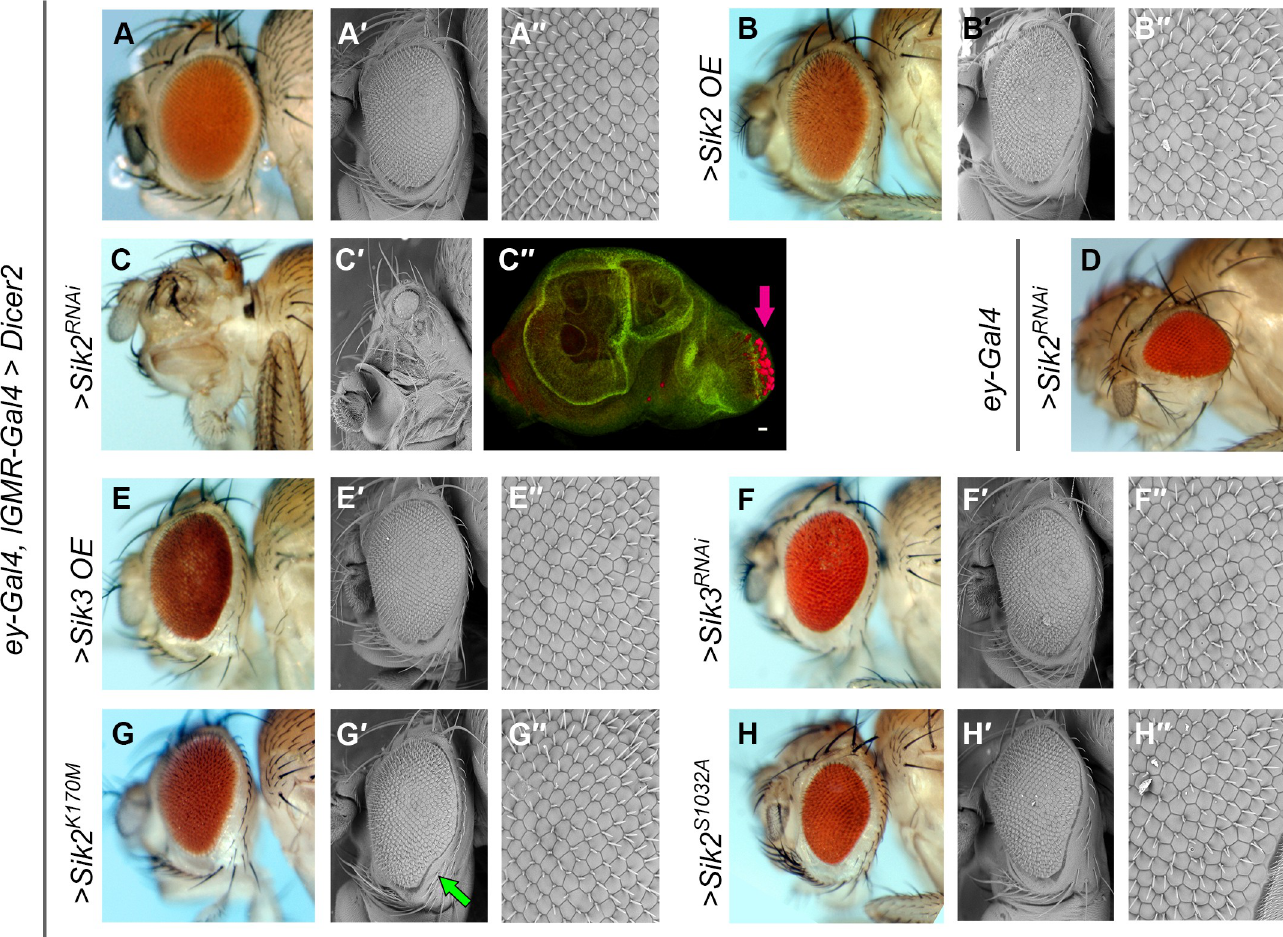
Fig 2. Eye morphology changes after manipulating Sik activity in the developing retina. Images in A, B, C, D, E, F, G, H represent light microscopy, A 0 , A 00 , B 0 , B 00 , C 0 , E 0 , E 00 , F 0 , F 00 , G 0 , G 00 , H 0 , H 00 scanning electron microscopy, C 00 , confocal microscopy images. In all cases except D, the flies are in “ UAS-Dicer2 / +; ey- GAL4 , lGMR-GAL4 / + ” background. (A-A 00 ) Control (driver crossed with wild type, w 1118 ). (B-B 00 ) Sik2 overexpression ( > Sik2 OE). (C-C 00 ) Sik2 knock-down ( > Sik2 RNAi ) (C 00 ) Third instar larval eye disc. Red is elav (neurogenic), pink arrow indicates the MF, green is Delta (non-specific stain, background signal). Scale bar 20 μ m. (D) Sik2 knock-down by ey -GAL4 driver and two copies of UAS-Sik2 RNAi . (E-E 00 ) Sik3 overexpression ( > Sik3 OE). (F-F 00 ) Sik3 knock-down ( > Sik3 RNAi ). (G-G 00 ) Sik2 kinase-dead ( > SIK2 K170M ). The green arrow indicates the ventral notch. (H-H 00 ) Sik2 constitutively active ( > Sik2 S1032A ). The full genotypes are listed in S2 Table. In all pictures, anterior is to the left, ventral is down.